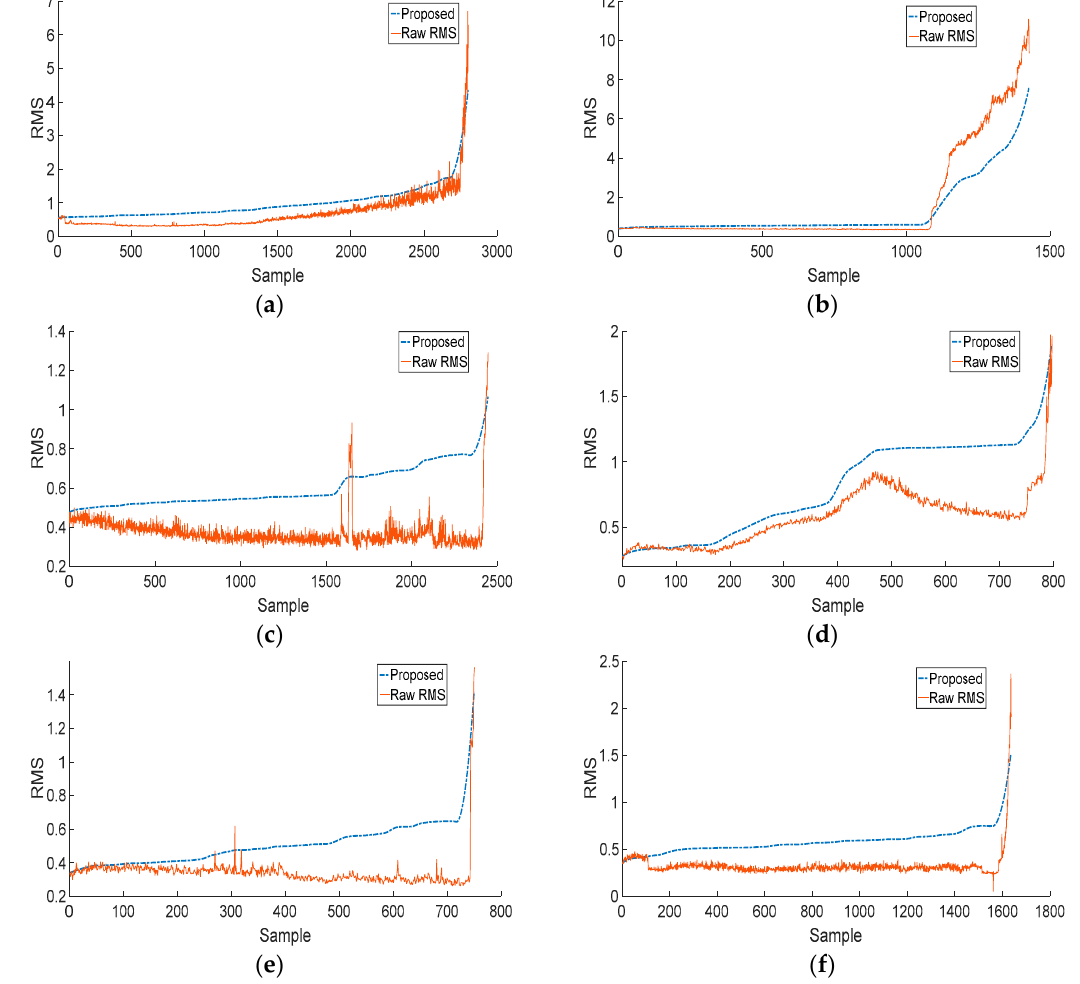
Figure 7. Comparison between the trend in RMS extracted directly from the vibration acceleration signal and the one extracted using the proposed method for ( a ) bearing 11, ( b ) bearing 14, ( c ) bearing 16, ( d ) bearing 22, ( e ) bearing 24, and ( f ) bearing 32 of the PRONOSTIA dataset.